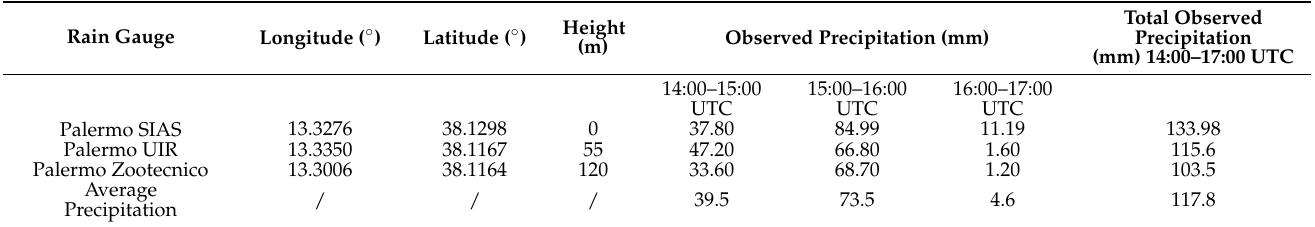
Table 1. Rainfall recorded in the period 14:00–17:00 UTC on 15 July 2020 for three rain gauges in Palermo. Rain Gauge